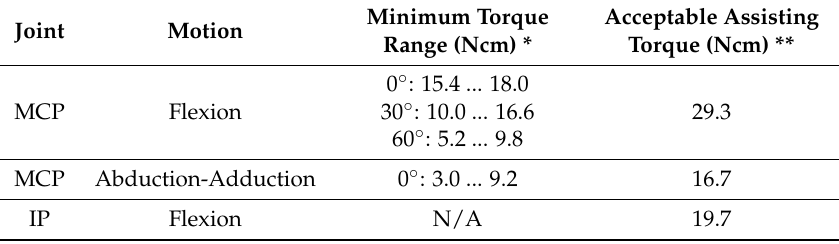
Table 2. Actuator torque